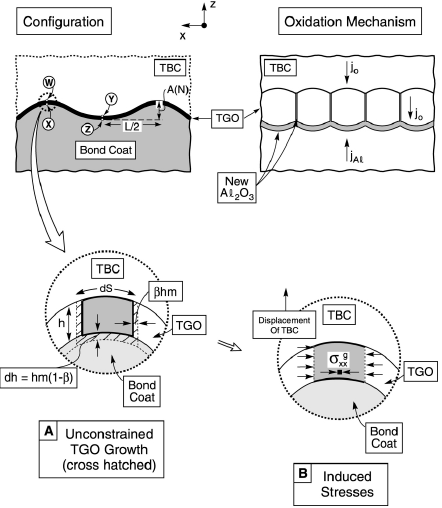
Figure 5. Schematics indicating the TGO growth modes and its implications for the development of growth stresses. Reprinted with permission from [8]; Copyright 2001 Elsevier.